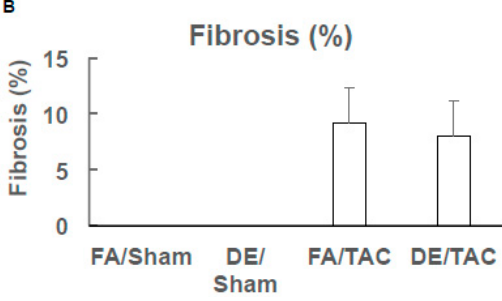
Figure 3. Effects of neonatal diesel particulate exposure and acute pressure overload on cardiac fibrosis. Neonatal mice were exposed to DE (300 µg/m 3 ) or FA (6 h/day, 5 days/week) from birth until weaning at 21 days and were then maintained in FA. Transverse aortic constriction (27 gauge needle) was done at 12 weeks of age. Animals were euthanized for organ harvest three weeks after surgery. ( A ) cardiac fibrosis was detected by Masson Trichrome staining; ( B ) quantification of fibrotic areas as a percentage of total area by Image J software (National Institutes of Health, Bethesda, MD, USA); FA/sham: n = 7; FA/TAC: n = 7; DE/sham: n = 6; DE/TAC: n = 7. There is no statistical difference between FA/TAC and